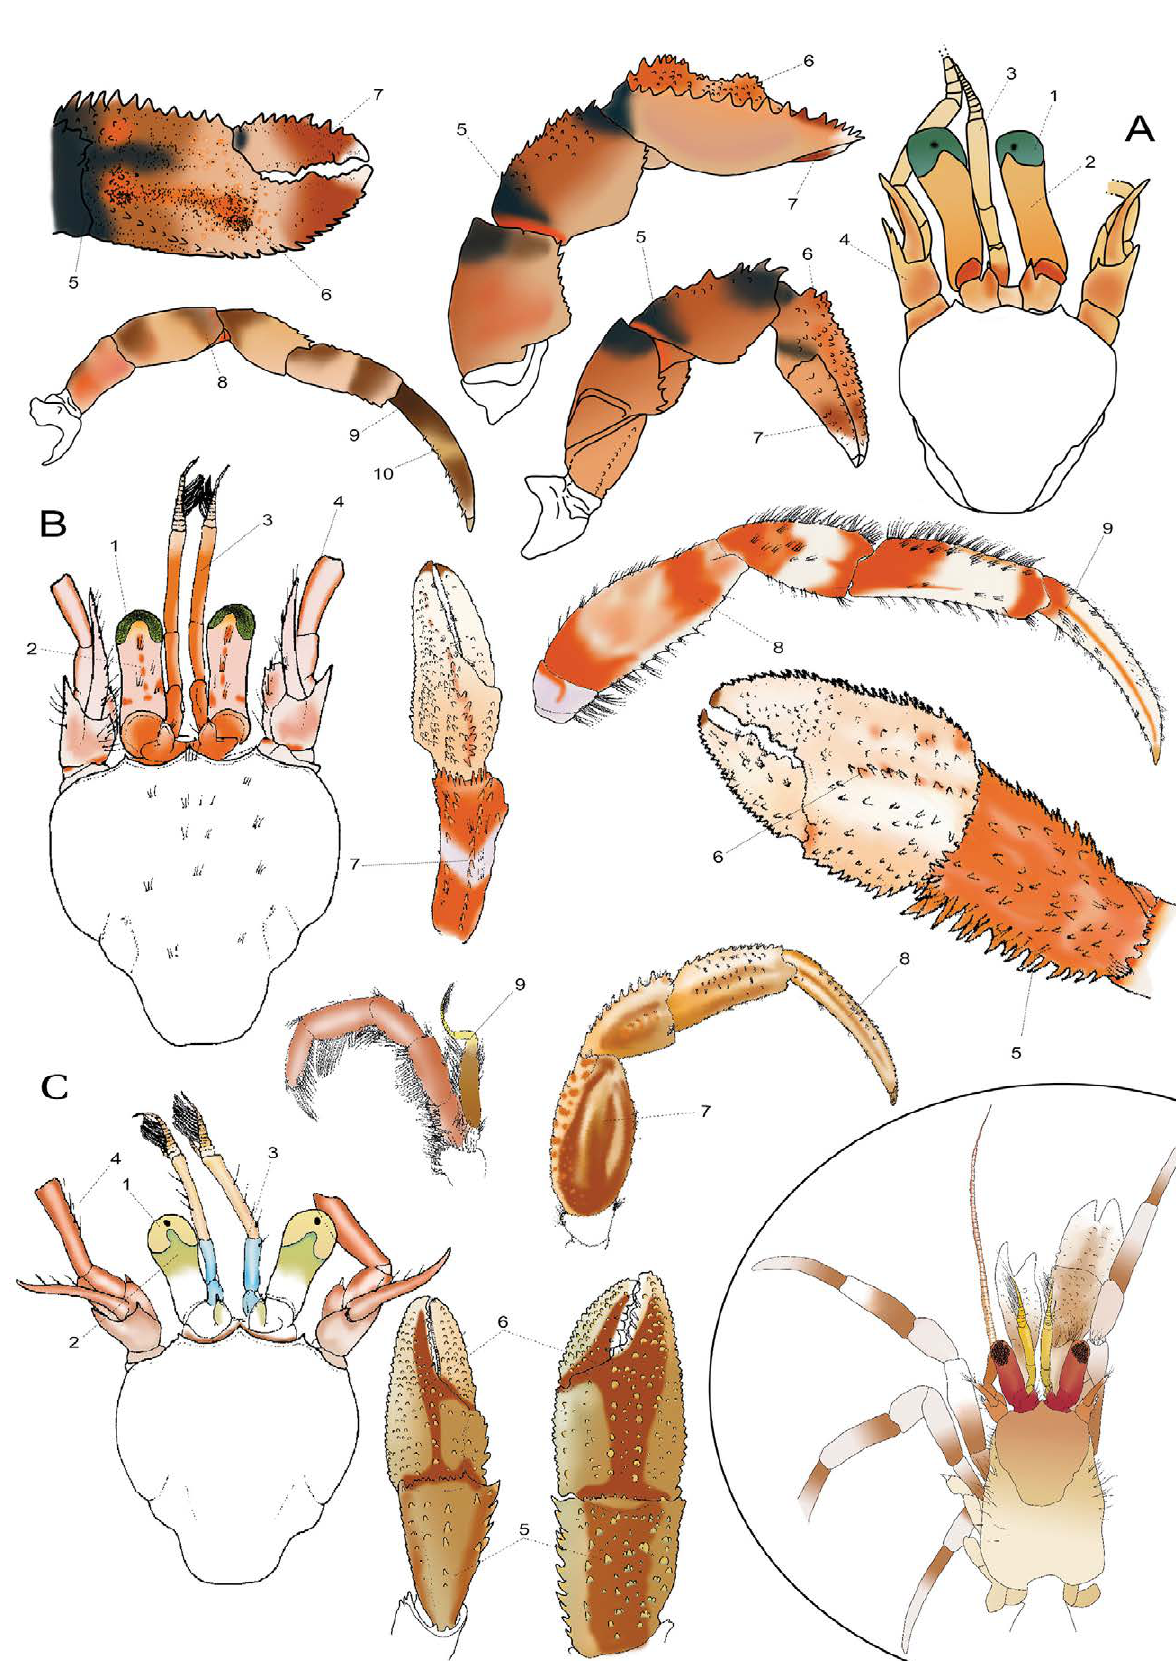
Fig. 11. – Colour patterns of Pagurus species: P. pseudosculptimanus (A, 1-10); P. pubescens (B, 1-9); P. bernhardus (C, 1-9; circled area corresponds to a juvenile). Vectorial drawings modified from A, García-Muñoz et al. (2014); B-C, Ingle (1993); juveniles of P. bernhardus (present